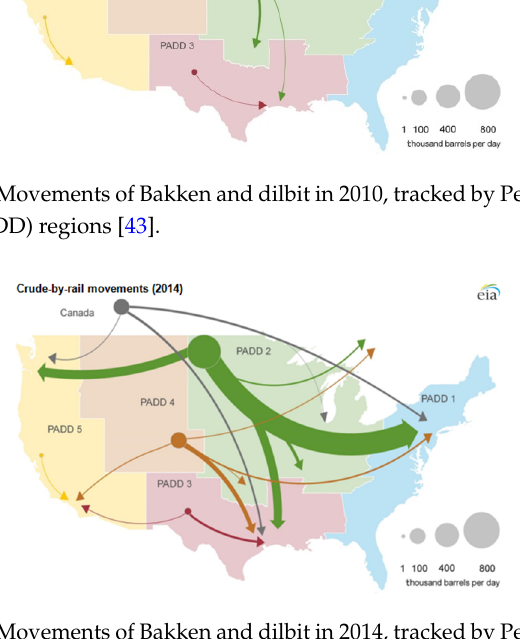
Figure 5. Crude ‐ By ‐ Rail Movements of Bakken and dilbit in 2014, tracked by Petroleum Administration for Defense District (PADD) regions [44].